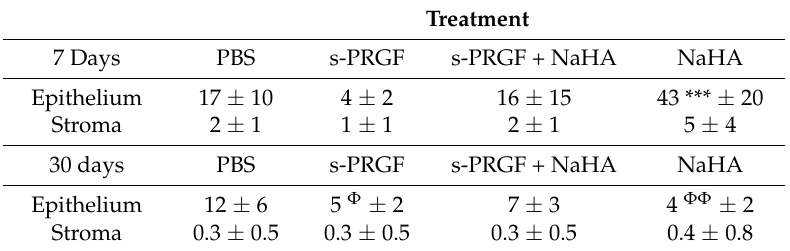
Table 2. Number of Ki67 positive cells in rabbit corneas treated with s-PRGF, s-PRGF and NaHA, NaHA, and PBS as the control. The results are expressed as mean number of cells ± standard deviation in seven different areas of the central corneas at 7 and 30 days after surgery.